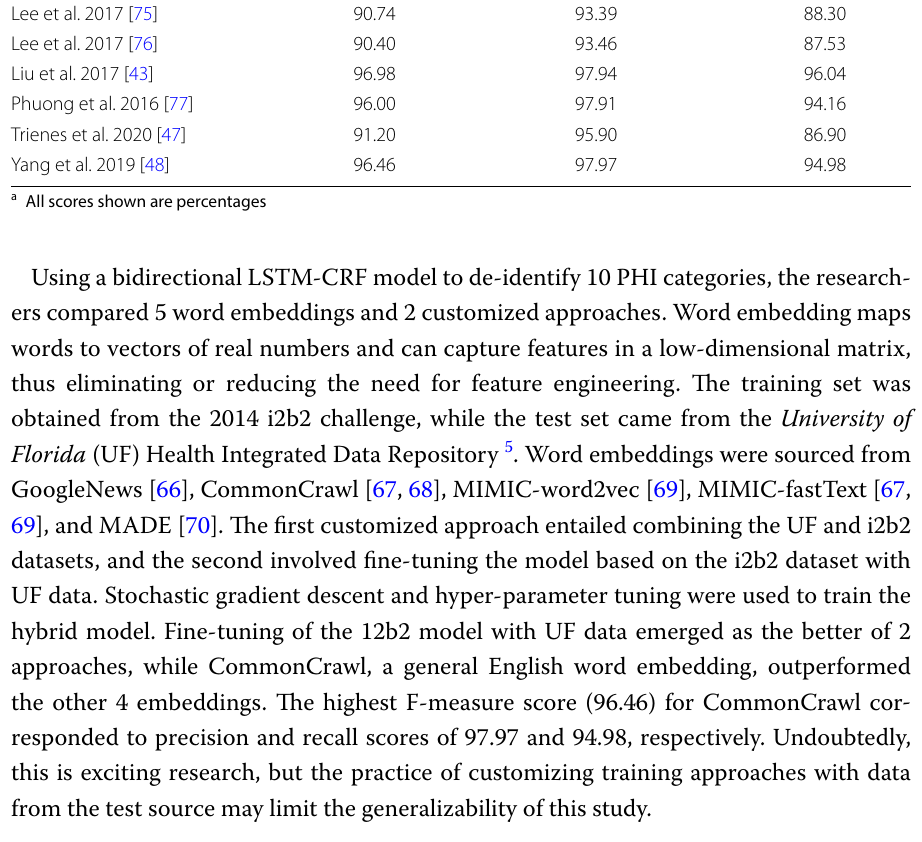
a All scores shown are